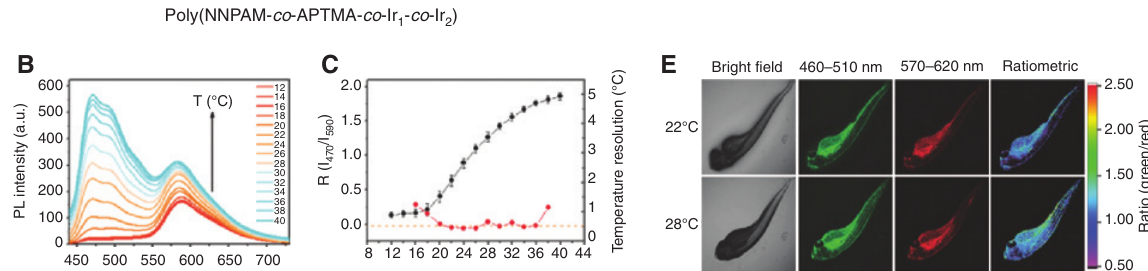
Figure 7: In vivo temperature sensing using poly(NNPAM- co -APTMA- co -Ir (A) Chemical structure of poly(NNPAM- co -APTMA- co -Ir (0.01 w/v%) in a PBS buffer (pH 7.4) ( λ [R(I /I ), black, left axis] in a PBS buffer (pH 7.4) and corresponding temperature resolution (red, right axis). (D) Phosphorescence images 470 590 of living HeLa cells that were labeled with poly(NNPAM- co -APTMA- co -Ir = 405 nm). (E) Bright field images (leftmost), phosphorescence images (second and third from the left, λ (right) ( λ ex responding ratiometric images (rightmost) of living zebrafish larva after microinjection of poly(NNPAM- co -APTMA- co -Ir with permission from Chen et al. (2016). Copyright 2016 John Wiley and